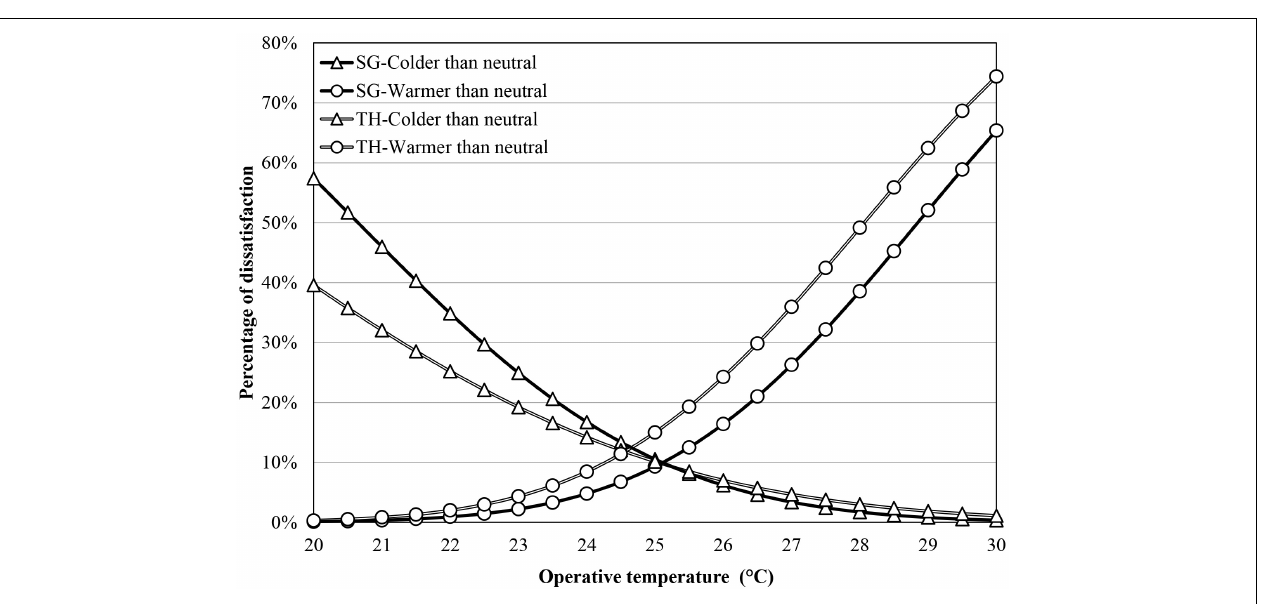
FIGURE 7 | Probit of dissatisfaction with respect to operative